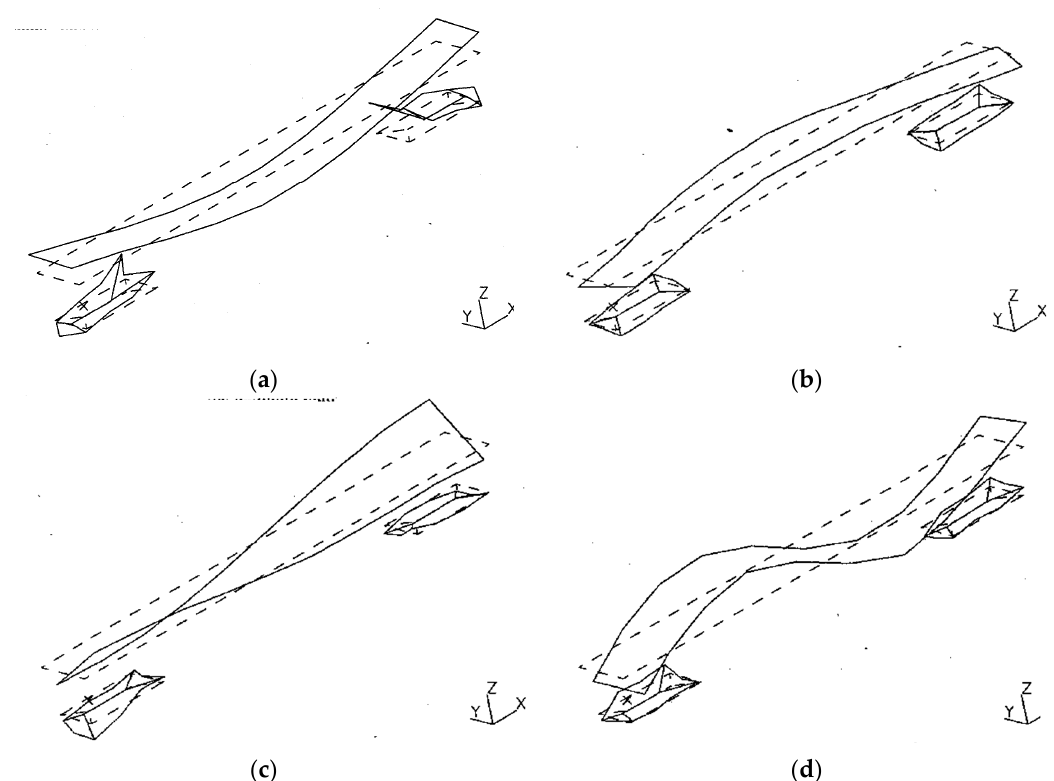
Figure 7. Measured modes of a passenger car [38] at ( a ) 9 Hz (vertical bending 1), ( b ) 11 Hz (lateral bending 1), ( c ) 14 Hz (torsional 1), ( d ) 18 Hz (vertical bending 2).